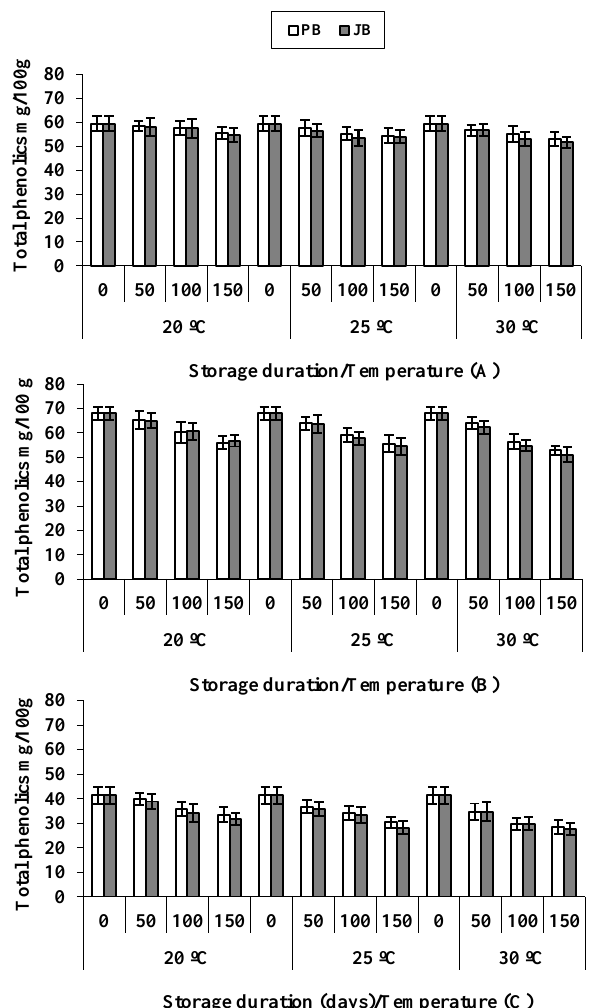
Figure 4. Total phenolic contents in hot peppers viz . Sky Red ( A ), Maha ( B ) and Wonder King ( C ) at different temperatures and packaging materials during five months’ storage. Vertical bars show + SD of n = 3